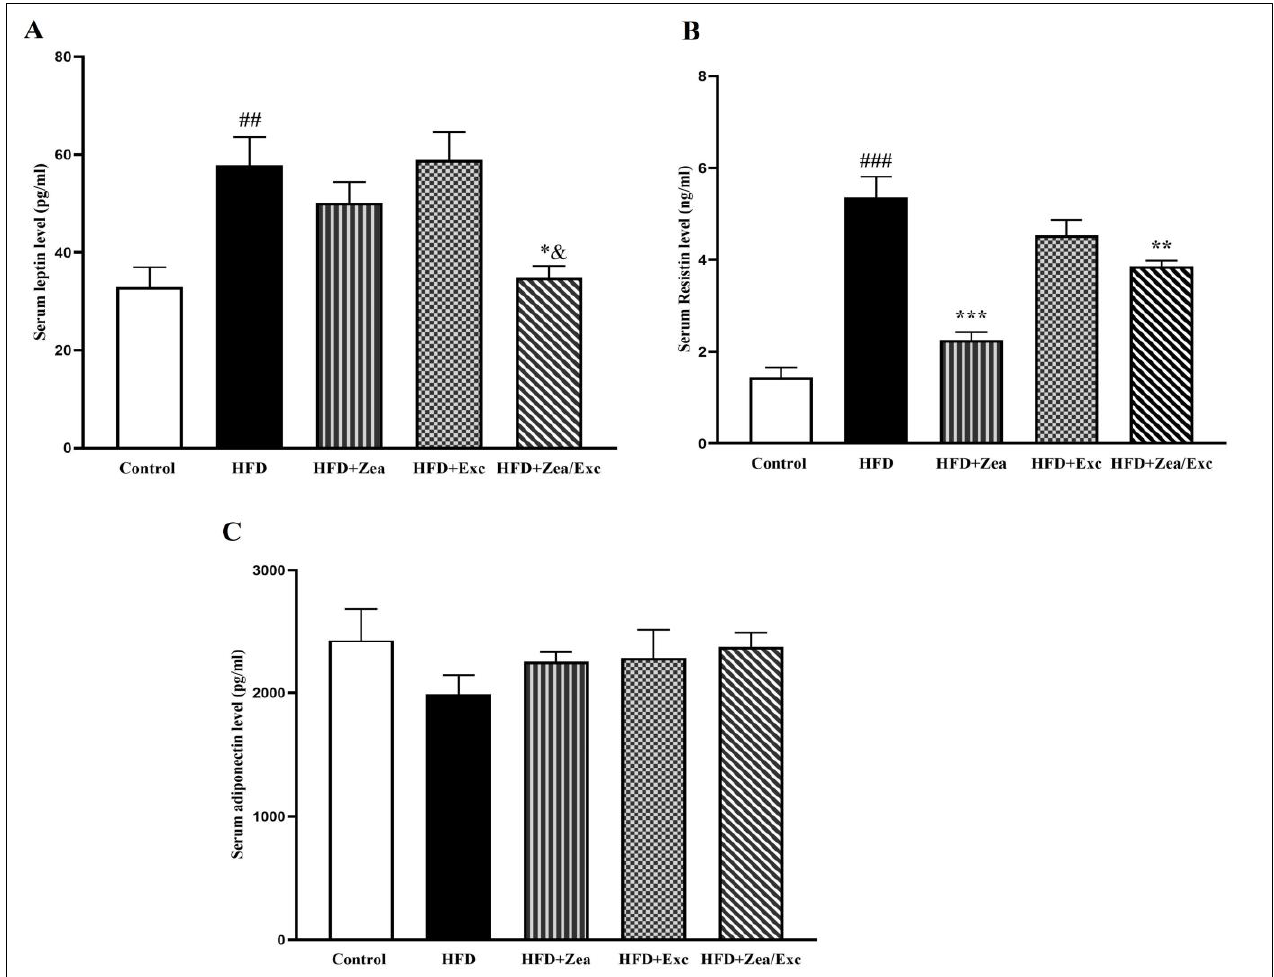
Figure 5. Effects of Zea and Exc on serum leptin levels ( A ), serum resistin levels ( B ), and adiponectin levels ( C ) in HFD-induced obese rats. Data are expressed as means ± SEM, n = 7. ## p < 0.01, ### p < 0.001 vs. control; * p < 0.05, ** p < 0.01, *** p ≤ 0.001 vs. HFD; & p ≤ 0.05 vs. HFD + Ex.